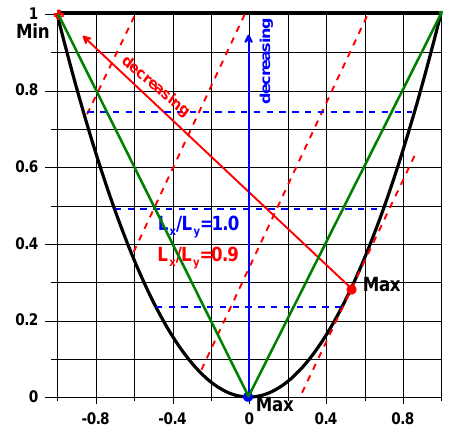
Figure 6. Contours of natural frequencies on the x , y plane for angle-ply and symmetric laminates—simply supported (SSSS) plates.